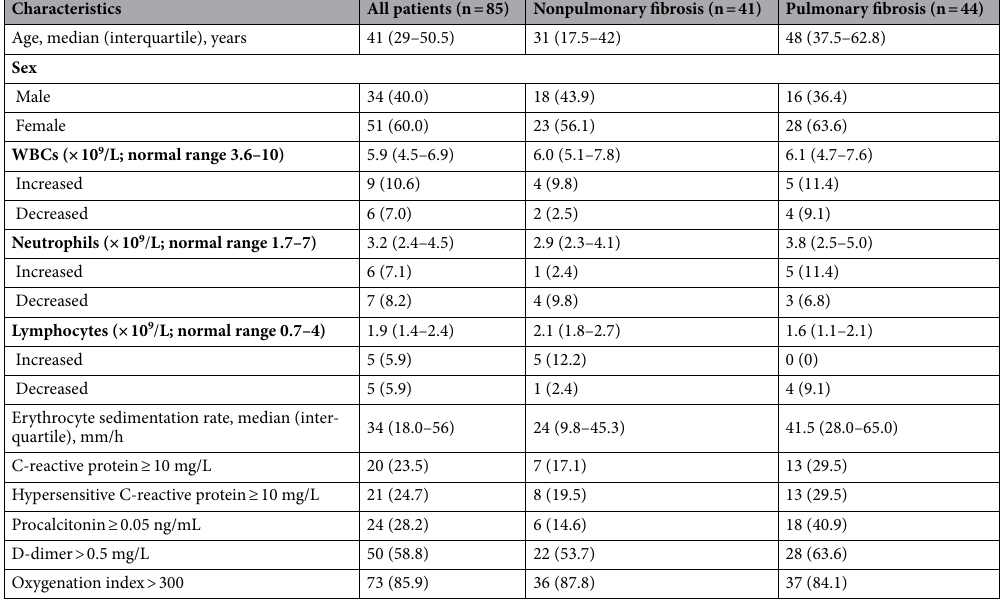
Table 1. Baseline characteristics of patients with Covid-19. Except where indicated, data are cases of patients, with percentages in